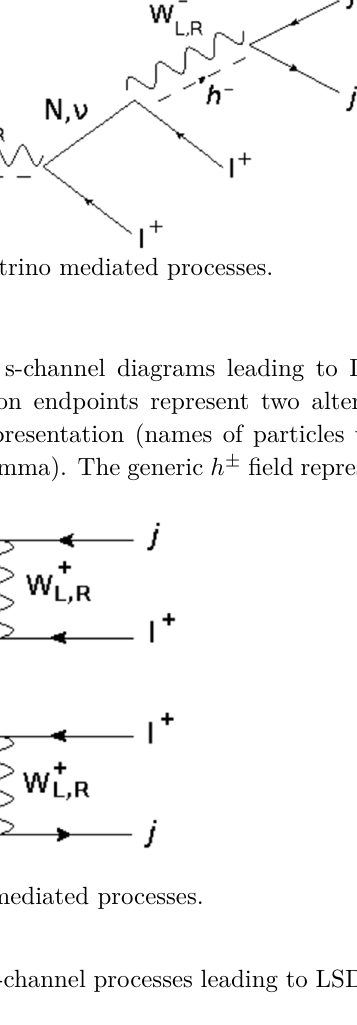
mediating Majorana neutrino or a mediating doubly charged Higgs boson in the diagram.